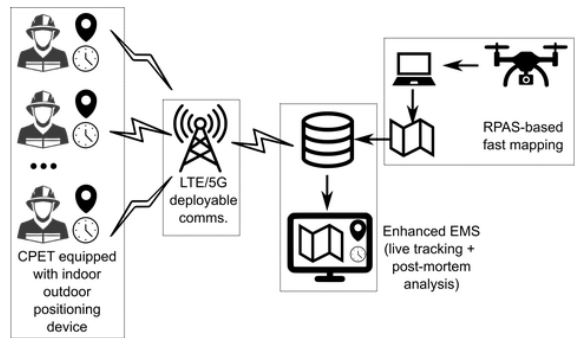
Figure 1 . IOPES project